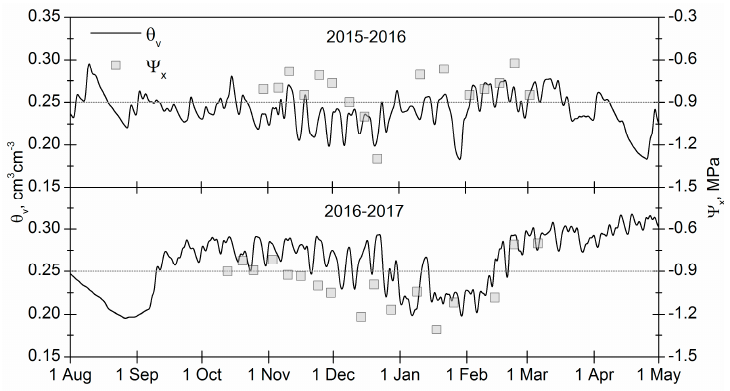
Figure 4 . Temporal evolution of soil water content ( θ v ) measured at a depth of 20 cm and stem water potential ( Ψ x ) in farmer irrigation treatment (T 0 ). Absolute values below − 0.9 MPa and descending trends in Ψ x indicate water deficit conditions. Table 3. Stem water potential ( Ψ x ) and standard deviation values (SD) measured before harvest (T 0 , regular management of the orchard; T 1 , under-irrigation; T 2 , over-irrigation).